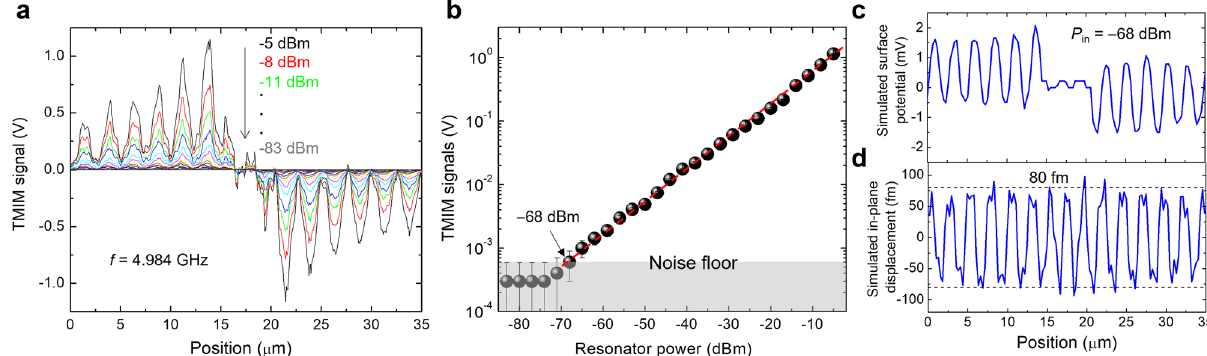
Fig. 5 | Analysis of TMIM sensitivity. a TMIM line pro fi les across the center of LOBAR at various input powers. b Maximum TMIM signal in ( a ) as a function of input power to the resonator. The noise fl oor corresponds to P in = − 68dBm. The